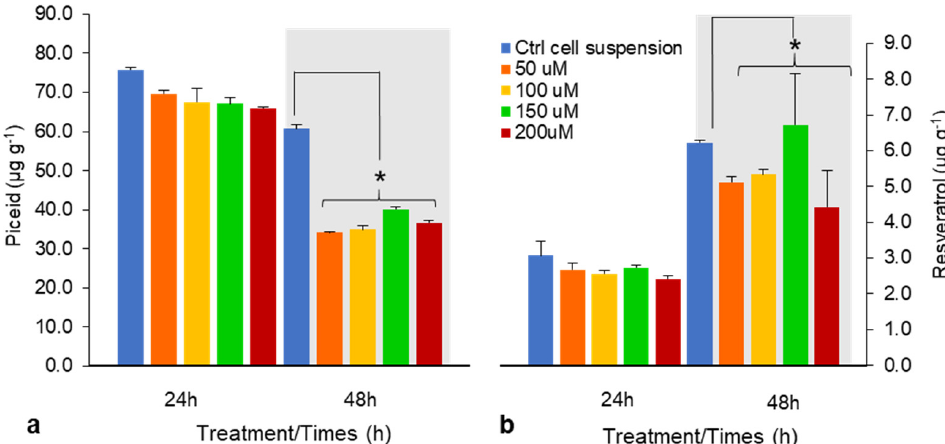
Figure 2. Effects of chitosan (CHI) on piceid ( a ) and resveratrol content ( b ) after 24 and 48 h treat- ments (50–200 μ M). Piceid and resveratrol yields are presented as means ± SD of three experiments. * p < 0.05 compared with untreated DJ526 cell suspension (control).